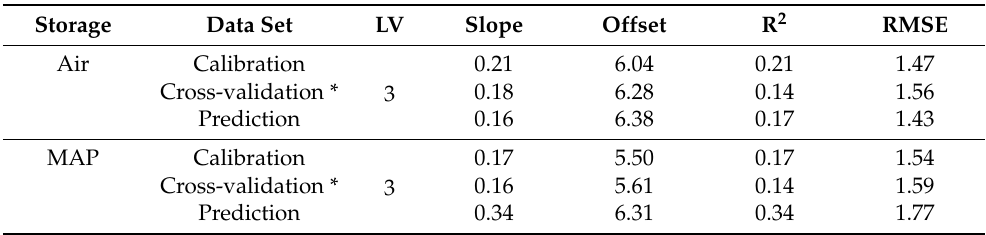
Table 4. Performance metrics of the PLS-R models developed on E-nose measurements for the estimation of TVC in gilthead sea bream fillet